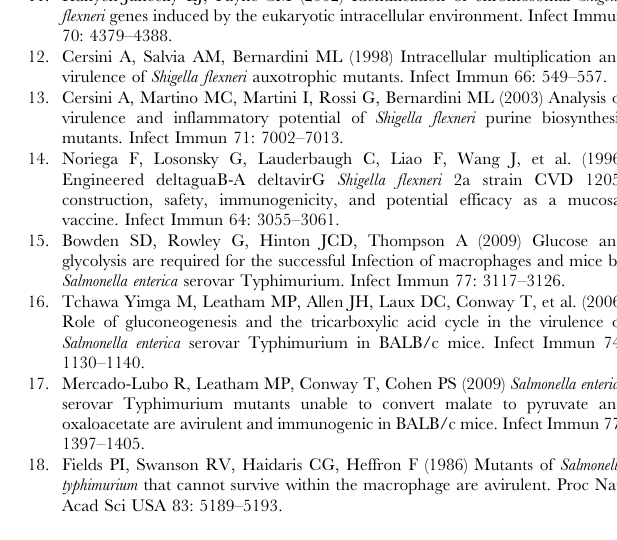
Table S2 Generation times of the studied enterobacterial pathogens during extra- and intracellular growth. The doubling times (DT in min) during growth of the bacteria in RPMI 1640, supplemented with 10 mM glucose (Glc), mannose (Man) or glucose 6-phosphate (Glc6P), or in Caco-2 cells were determined by measuring the bacterial cell density (at OD600) and the colony forming units (cfu), respectively. Also shown (right to the doubling times) are the highest bacterial densities reached during growth. Note that there is a low growth background of about OD600 = 0.2 even in the absence (w/o) of Glc, Man or Glc6P. Doubling times during infection of Caco-2 cells were averaged from time point 1 to 6 h post infection (p.i.). for the EIEC strains and from 0 to 8 h p.i. for Stm 14028. The construction of the mutants and further details of their properties are published in [32]. Table S3 13 C-Excess (%) per C-atom in amino acids from experiments a- b , for details see Figure 2. Table S4 13 C-Isotopologue abundance of amino acids from all experiments in mol%. The labelling pattern is given in terms of XY-groups (Ro¨misch-Margl et al., 2007). This notation is based on digits for each C-atom. The first digit represents C-1, the second C-2, etc.; 1 signifies 13 C, 0 signifies 12 C, and X and Y signify either 13 C or 12 C. While the labelling status of X is totally undefined, the overall number of 13 C labelled atoms of Y is known and written outside the brackets. Two independent labelling experiments were analyzed if not indicated otherwise. Table S5 13C-Excess (%) per C-atom in amino acids from experiments a-n, for details see Figure